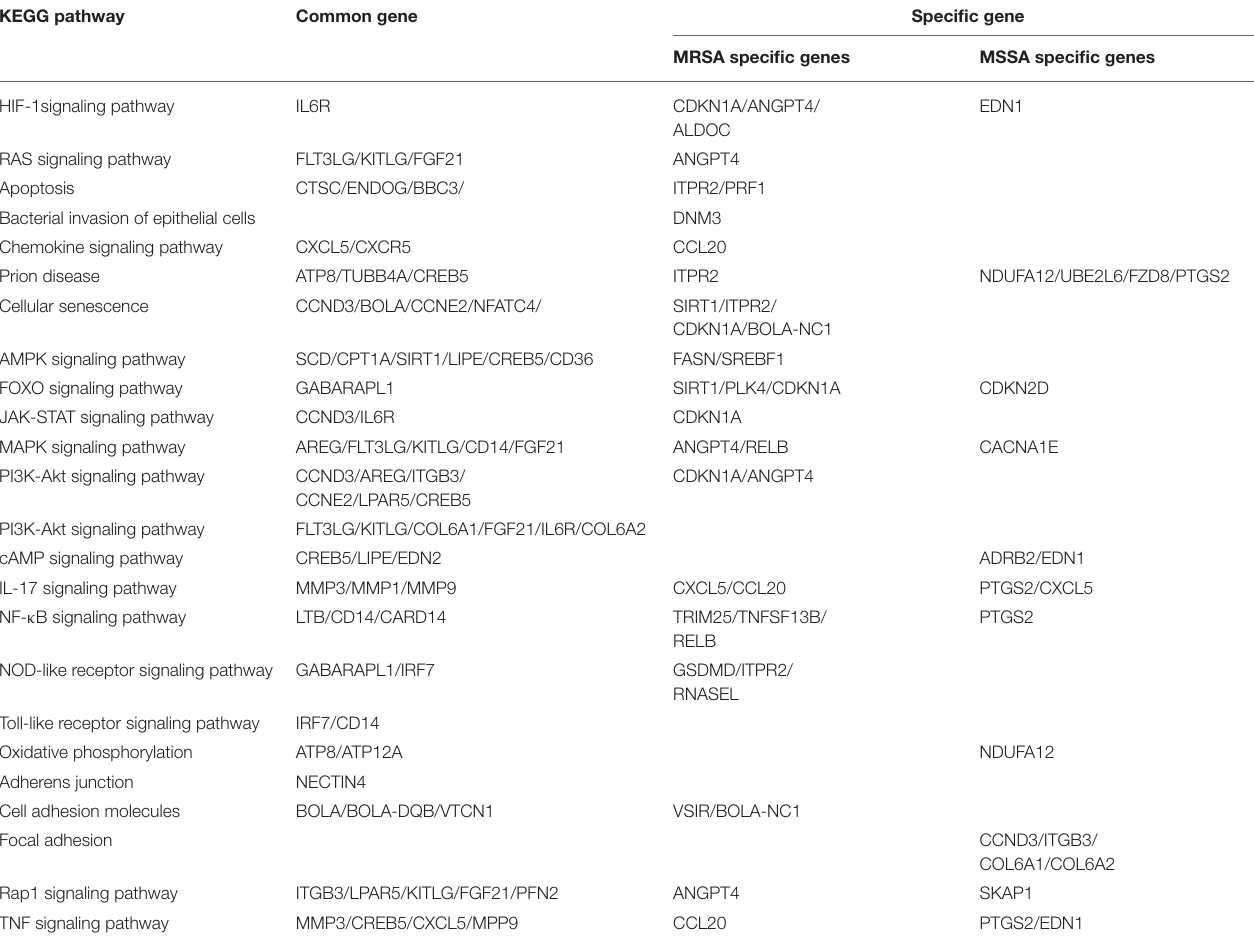
TABLE 3 | KEGG pathway enrichment analysis of MRSA-infected and MSSA-infected MAC-T cells. KEGG